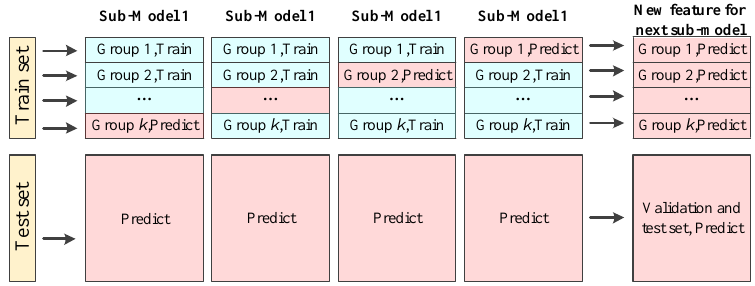
Figure 2. The framework of k-fold cross-validation for reactive power optimization.